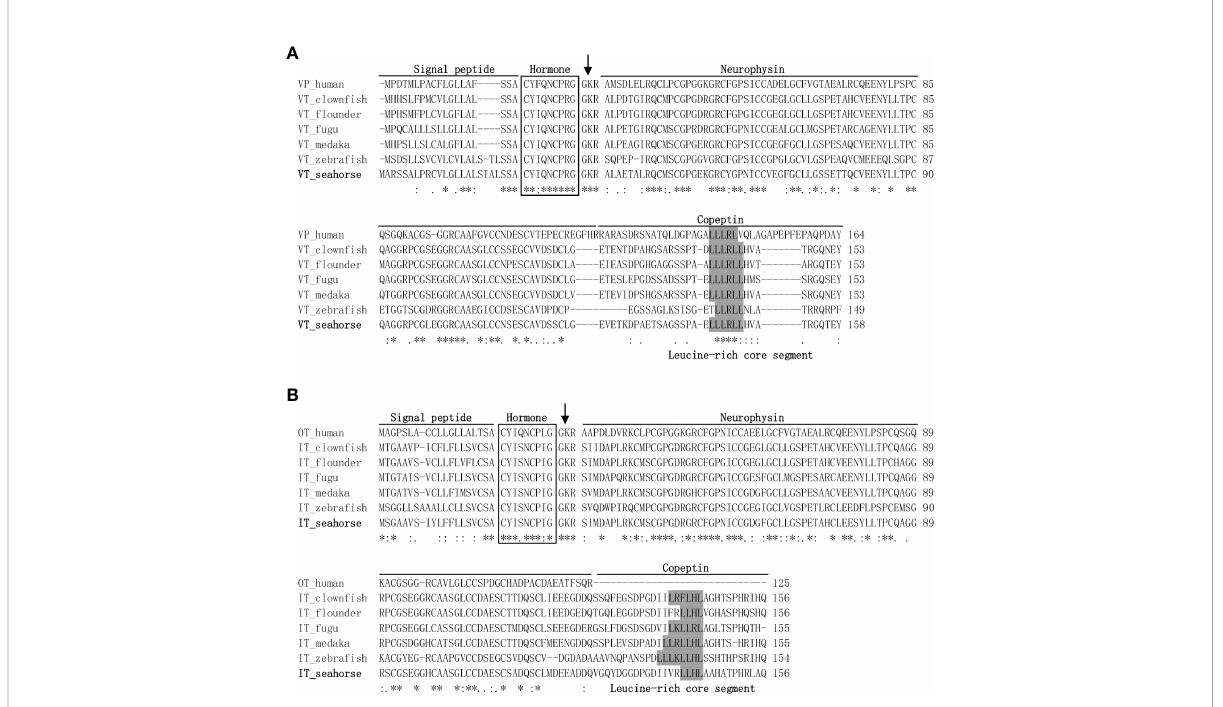
FIGURE 1 Genetic structure and multiple sequence alignments of vasotocin (VT) (A) and isotocin (IT) (B) . The mature hormone peptides are boxed, and the GKR cleavage site was marked with an arrow. Genetic structures, including a signal peptide, neurophysin, and copeptin parts, were lined out. GenBank accession numbers for teleost VT and IT proteins are listed in Table 2. Symbol asterisks means that the amino acid residues in that column are identical in the